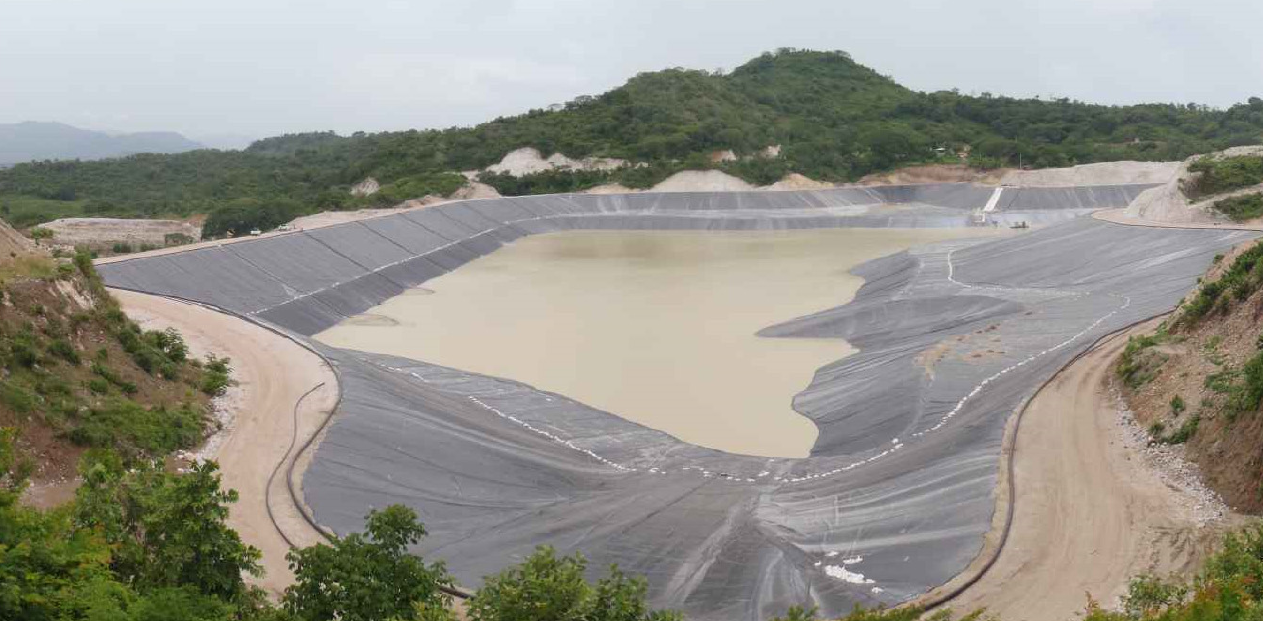
Figure 29. Example of use of geosynthetic liner in the zone of a TSF in contact with rock–TSF Peru.